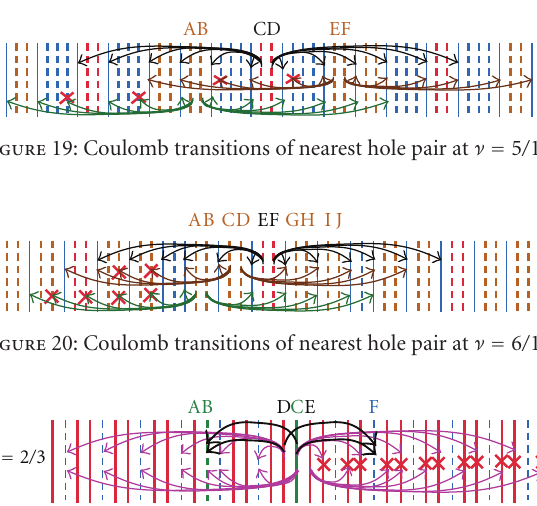
Figure 21: Electron configuration in excited state #1 at ν = 2 /